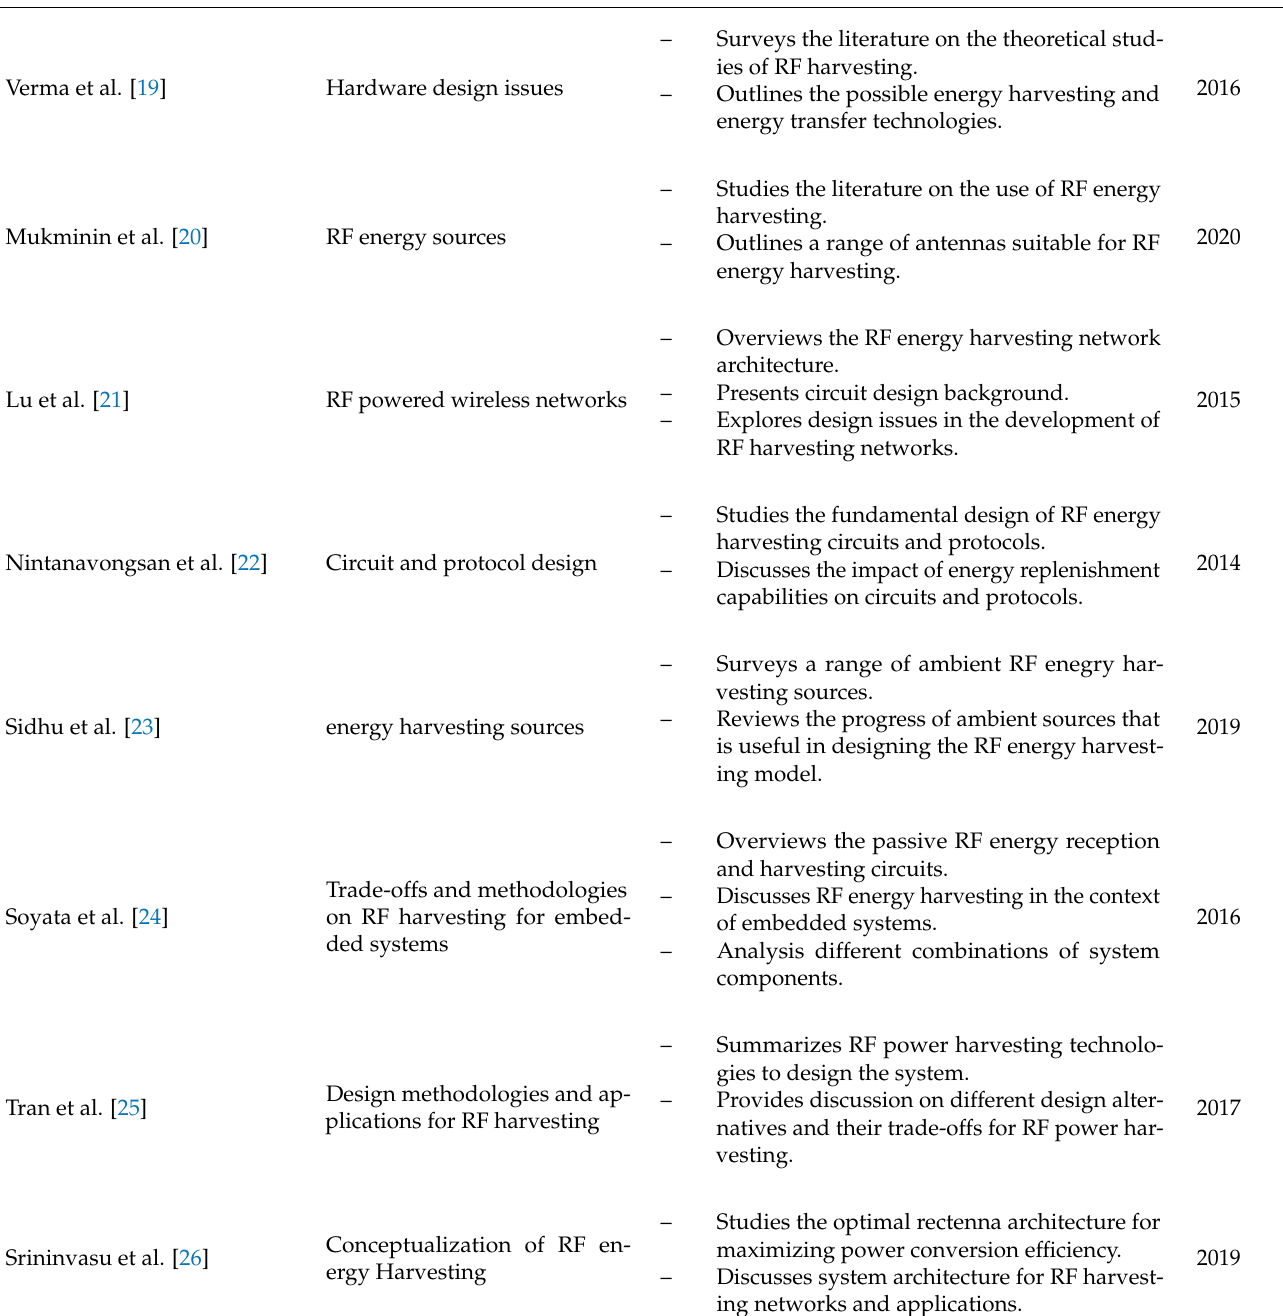
Table 3. A summary of the state of the art surveys on RF power